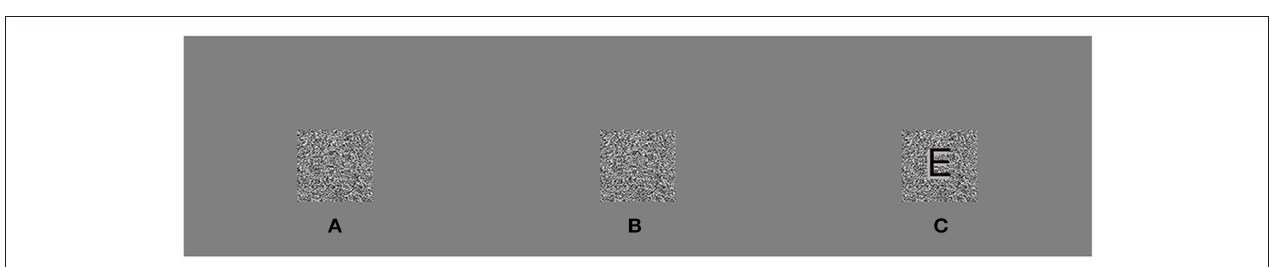
FIGURE 3 | Legend of random-dot stimulus. In the correct test position, the left eye perceived an A and the right eye perceived a B. When the eyes properly fused (A,B) , the central optotype “E” seemed to jump out of the plane [ (C) , “E” was only outlined for visibility and not truly present].